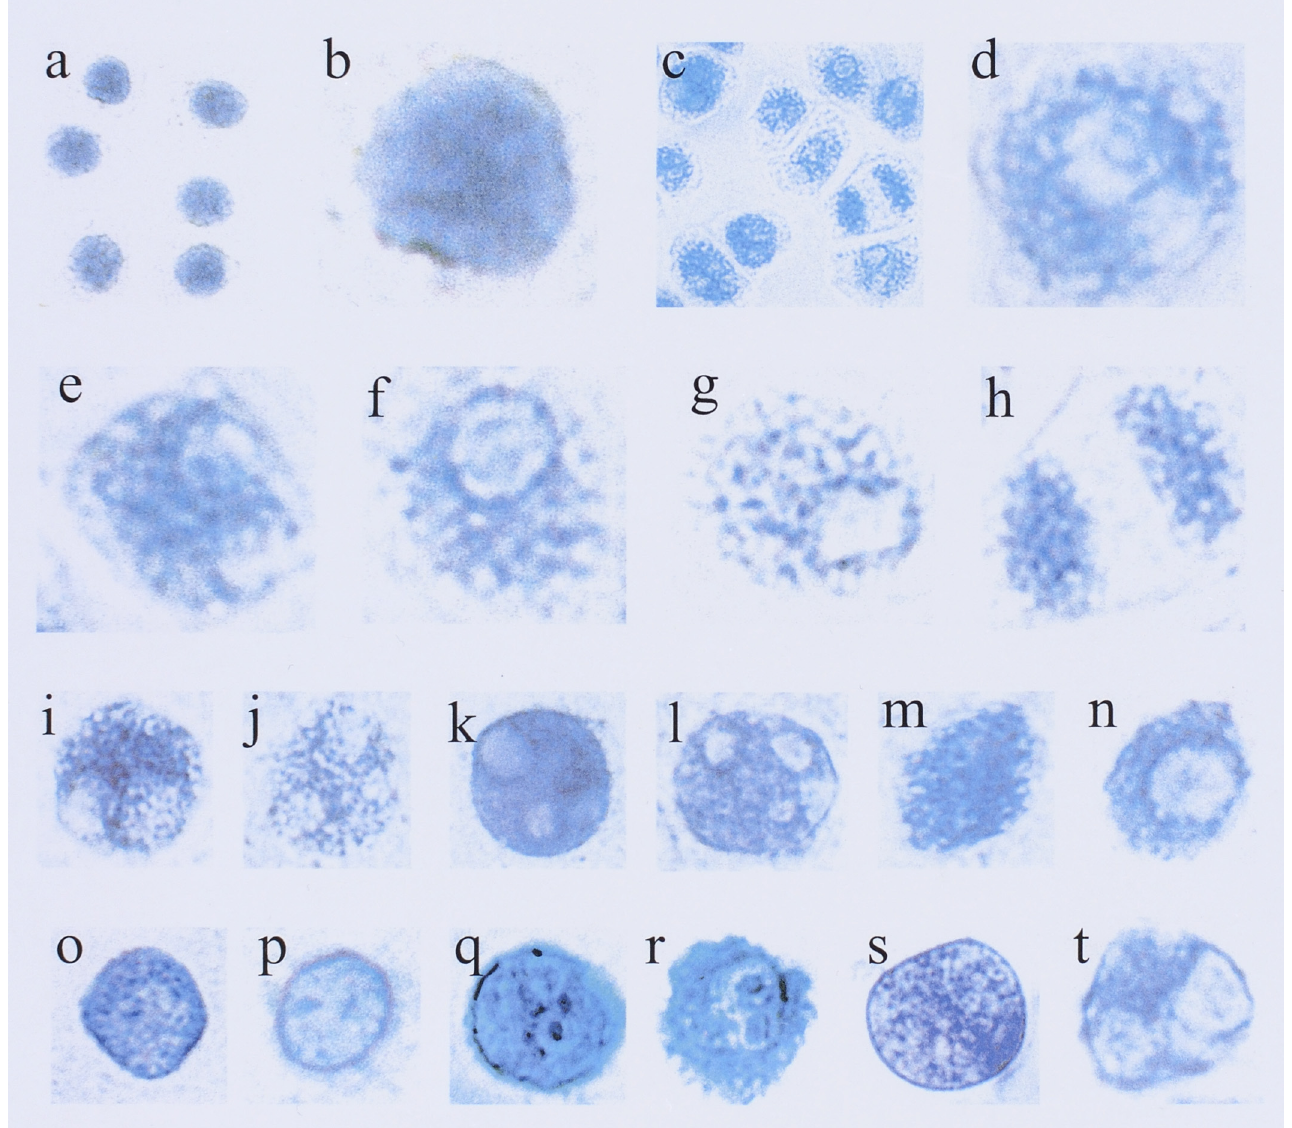
Fig. 1: Endogenous nuclear flavanols from Camellia sinensis and externally added flavanols (EGCG and green tea) to nuclei of herbaceous plants and humans. Absorbance units (AU) measured at 640 nm are given in [brackets] as single values or as the mean ± standard deviation for the nuclei visible in the figures. Diameters of the nuclei from tea bush range from 7 to 9 µm including those of Fig. 1a and 1c. a. Silenced nuclei from the mature anther epidermis (7 µm in diameter) [AU 66.6 ± 2.1]. b. Magnification of one diffuse nucleus from Fig. a [AU 68.4]. c. Activated nuclei of a young anther during maximal cell cycling representing a meristematic cluster [60.1 ± 7.8]. d-g. Magnification of activated nuclei showing the typical mosaic pattern of flavanols. [AU: d, 57.2; e, 59.0; f, 48.1; g, 24.4] h. Developing daughter cells of telophase with euchromatin interspersed with sharply mottled, darkly stained blobs of heterochromatin [AU 57.4; 63.5]. Herbaceous nuclei from Hyacynthus (i, j, Tulipa (k, l) and Allium (m, n). EGCG (i, k, m) [AU: i, 66.0; k, 71.9; m, 74.1] and green tea (j, l, n). [AU: j, 44.0; l, 63.9; n, 60.0], Diameters of the nuclei range from 8-9 µm. Human nuclei from nasal mucosa (o, p), saliva secretion (q, r) skin (forehead) epidermis (s, t). EGCG (p, r, t) [AU: p, 51.1; r, 78.0; t, 49.2] and green tea (o, q, s) [AU: o, 73.4; q, 79.; s, 65.3] Diameters of the nuclei range from 5-6 µm. blotches, and a large part of the envelope line is exceptionally dark heavily stained dots and a partially darkly blue border line around blue. The second nucleus (Fig. 1 r), imbibed in green tea, shows the nucleolus. curious morphological details. The envelope is without flavanol An epidermal skin cell (forehead) treated with EGCG developed reaction, probably a sign of degeneration. Also the organization of throughout the nuclear area a number of tiny but deep blue spots the nucleolar region appears to be anomal, as evidenced by two which are clearly interrupted by fairly pale blue areas (Fig. 1 s).